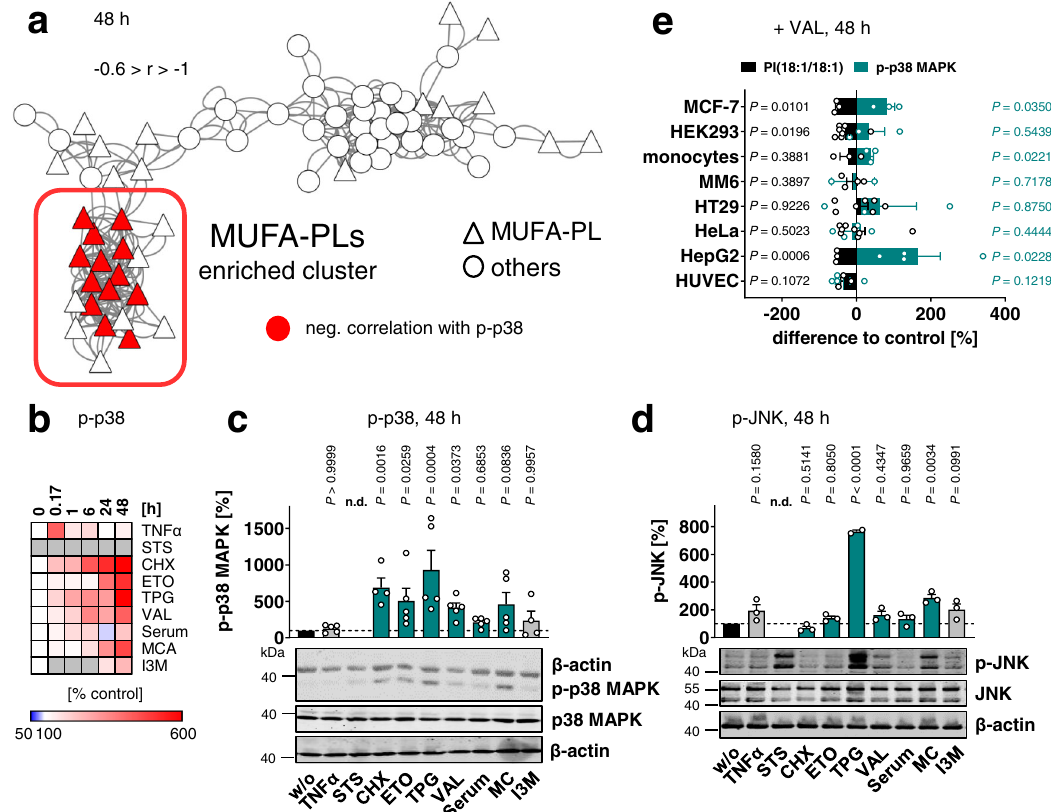
Fig. 2 p38 MAPK activation accompanies the early cytotoxic decrease of MUFA-PI. Fibroblasts were cultivated under diverse cytotoxic conditions for 48h or as indicated. a Negative correlation ( − 0.6> r > − 1) between cellular p-p38 MAPK (Thr180/Tyr182) levels (at 48h) and the proportions of phospholipid (PL) species are shown for the co-regulated lipid network described in Supplementary Fig. 1a. Correlations were calculated for mean p-p38 MAPK levels from three independent experiments. b Heatmap showing time-dependent changes in the activation of p38 MAPK compared to vehicle control for each time point. Representative Western blots are shown in Supplementary Fig. 2a. STS, excluded due to pan-kinase inhibition; gray color for I3M, not determined. c , d Phosphorylation and expression of p38 MAPK ( P = 0.99995) ( c ) and JNK ( P = 0.000007) ( d ). Western blots are representative of fi ve ( c ) or three ( b , d ) independent experiments. Data of c is identical to w/o in Supplementary Fig. 13b, 16b and 25a. Mean ( b ) or mean + s.e.m. and single data ( c , d ) from n = 1 ( b I3M for 24h), n = 2 ( b TNF α for 0.17h, d for TPG), n = 3 ( a , b , d ), n = 4 ( b , c for CHX, I3M at 48h), n = 5 ( b for 48h, c ) independent experiments. P values given vs. vehicle control; mixed-effects model (REML) + Tukey HSD post hoc tests of log data ( c , d ). e Counter-regulation of PI(18:1/18:1) ratios and p38 MAPK activation during VAL-induced cell death across cell lines. MCF-7 breast adenocarcinoma cells, HEK293 embryonic kidney cells, primary human monocytes, MM6 acute monocytic leukemia cells, HT29 colon adenocarcinoma cells, HeLa cervical carcinoma cells, HepG2 hepatoma cells, and HUVECs were treated with vehicle or VAL (10 µ M) for 48h. Percentage changes in cellular PI(18:1/18:1) ratios and p-p38 MAPK levels were calculated vs. vehicle (100%), and the difference to the vehicle control is presented. Representative Western blots are shown in Supplementary Fig. 2b. Detailed descriptions of datasets shown in panel e are given in Supplementary Note 2. P values given vs. vehicle control; two-tailed paired student t